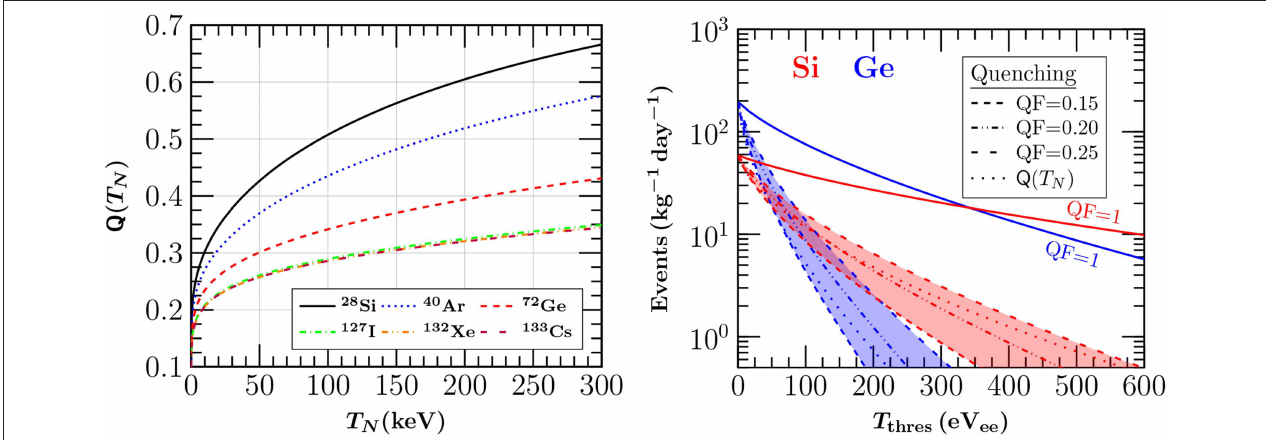
FIGURE 6 | (Left) The QF as a function of the nuclear recoil energy. (Right) The impact of the QF on the expected number of events at a reactor based experiment assuming a typical neutrino flux of 10 13 cm − 2 s − 1 for CE ν NS off Silicon and Germanium detectors. The figure in the left panel has been adapted from Miranda et al. [22] under the terms of the Creative Commons Attribution 4.0 International license.